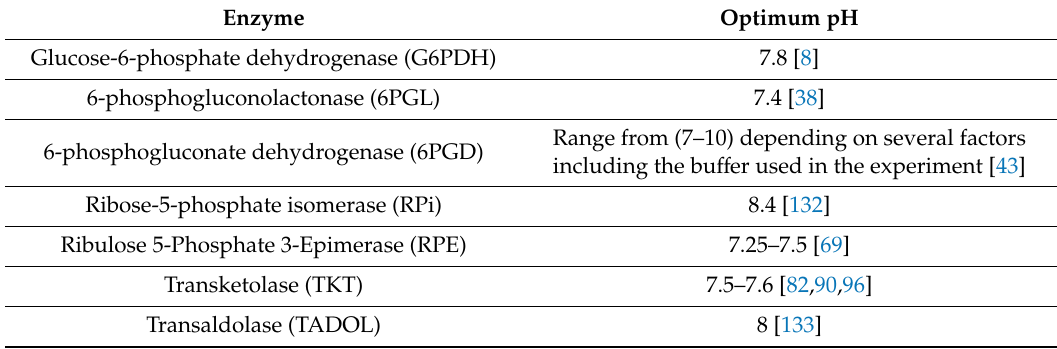
Table 1. Optimum pHi for each PPP driving